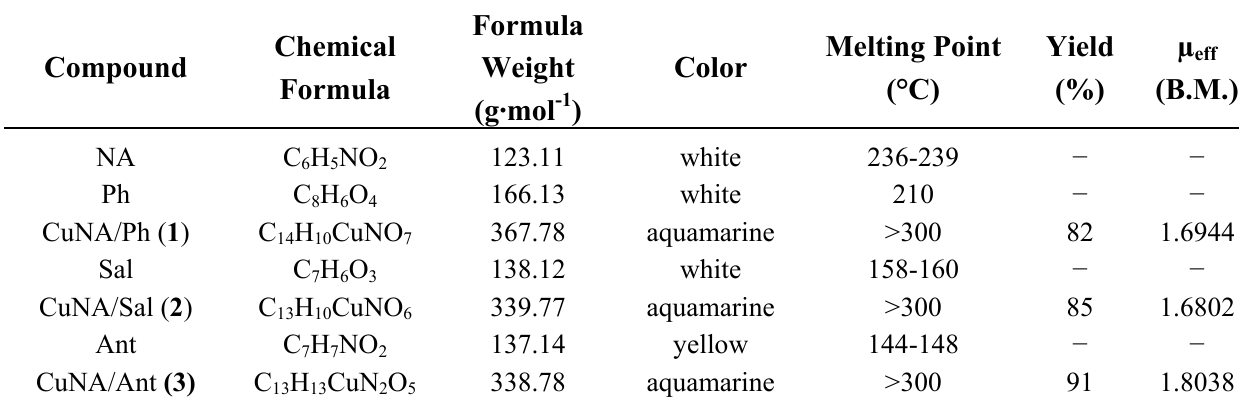
Table 1. Physicochemical parameters of nicotinic acid-copper complexes and ligands.